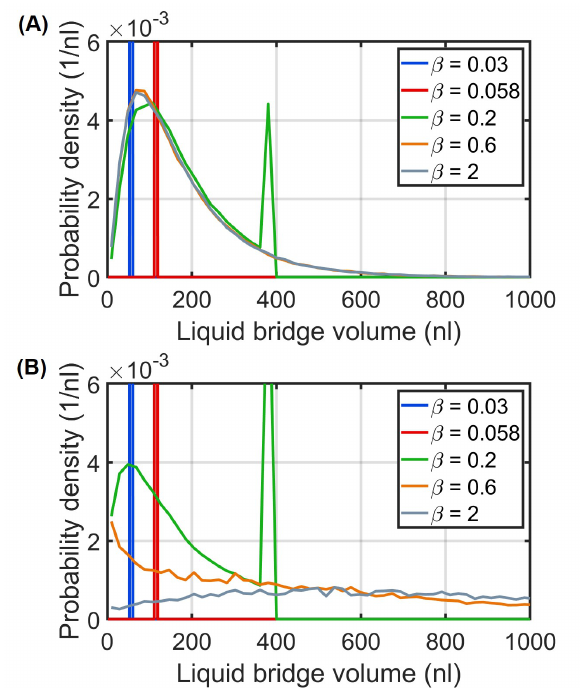
Figure 5. Probability density function of the capillary bridge volumes for various values of maximum bridge volume β , and for liquid distribution coe ffi cient (A) C D = 0 . 5, and (B) C D =